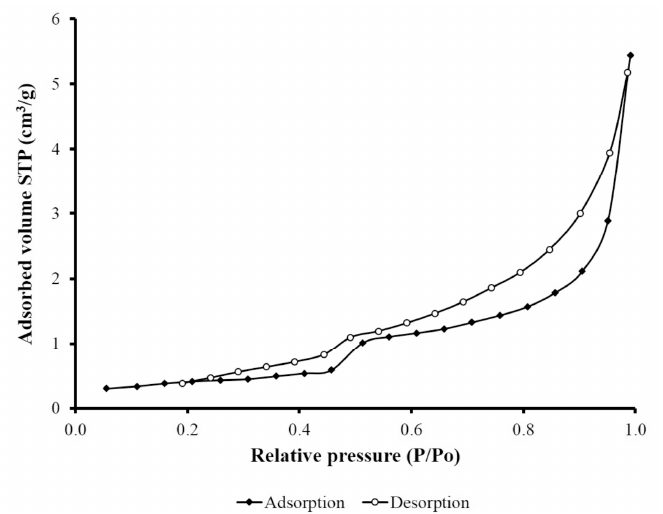
Figure 2. N 2 adsorption-desorption isotherm of tezontle .